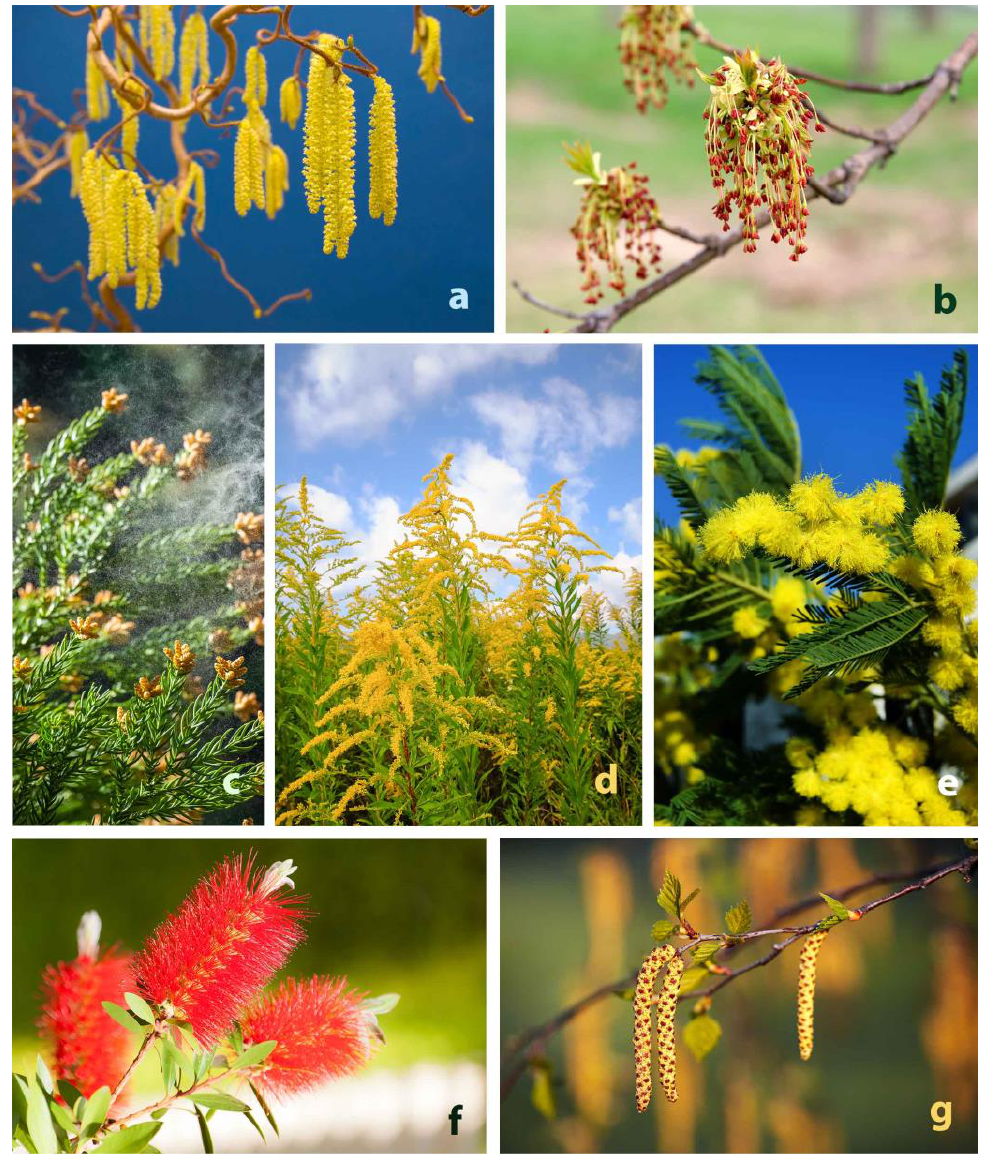
Figure 4. Recommended plant species for illustrating visual marketing materials of allergy-related products. ( a ): Corylus avellana , ( b ): Acer negundo , ( c ): Cryptomeria japonica , ( d ): Solidago canadensis , ( e ): Acacia dealbata , ( f ): Callistemon sp., ( g ): Betula pendula . Source: stock.adobe.com (accessed on 10 December 2022) (account NPHC).